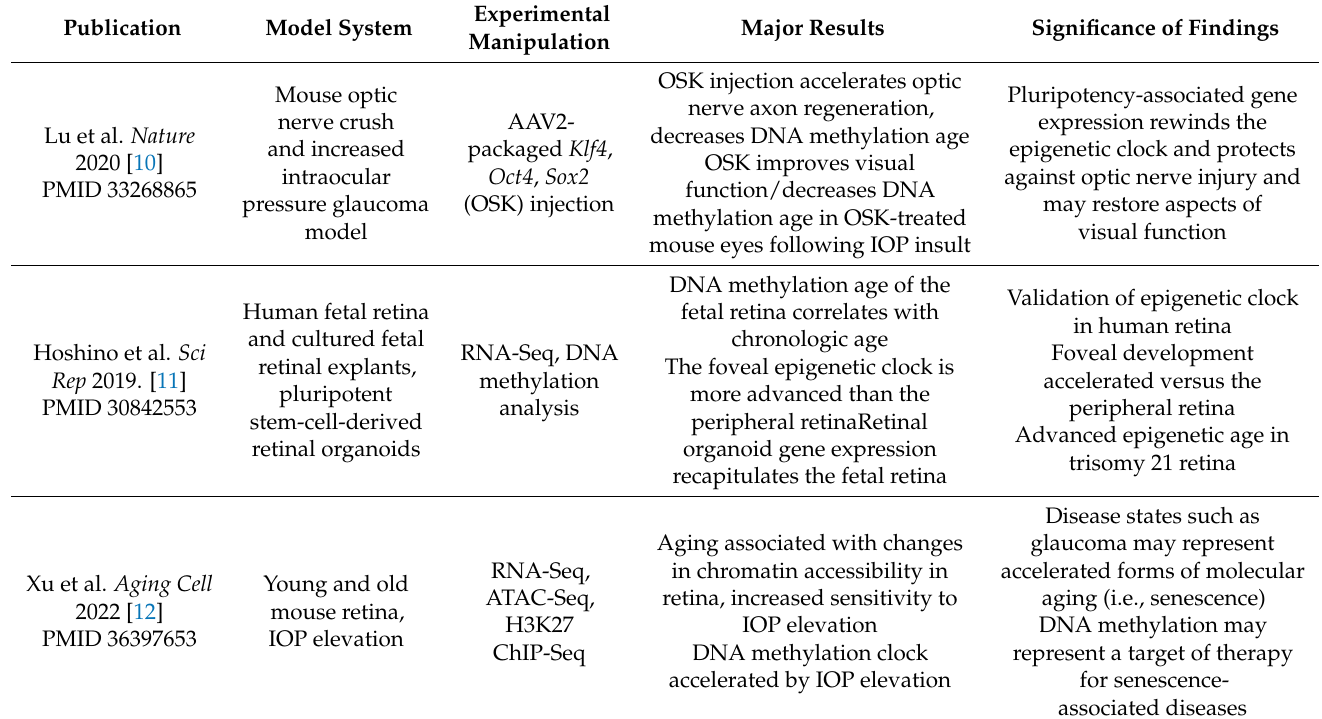
Table 1. Seminal findings from selected publications of epigenetic advances in retinal aging and